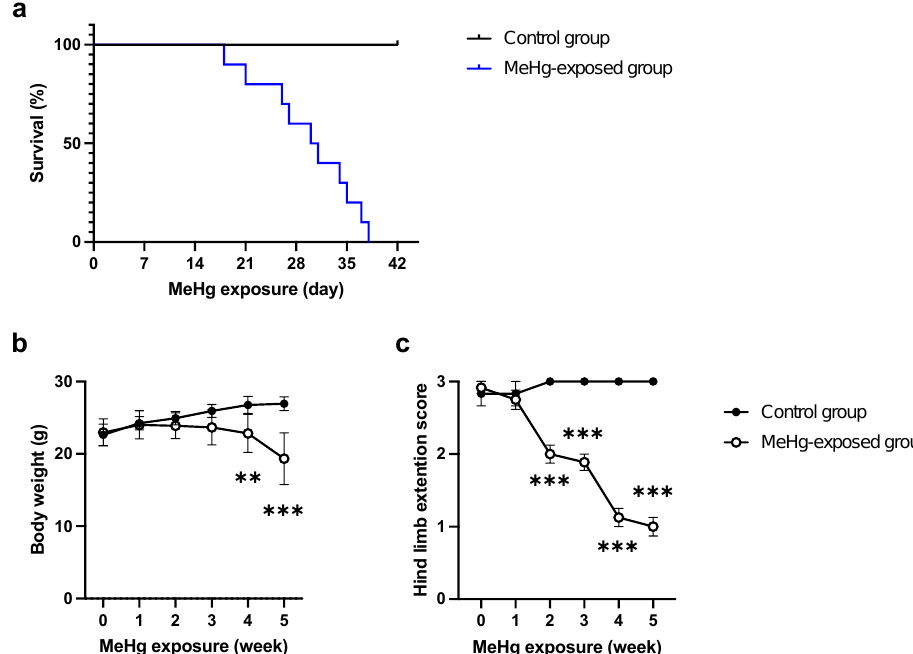
Figure 1. Sensitivity to MeHg exposure in ERAI-Venus mice in vivo. Mortality ( a ), body weight ( b ), and hind limb extension ( c ) in MeHg-exposed ERAI-Venus mice. MeHg-exposed mice were administered 50 ppm MeHg via drinking water. Data are expressed as the mean ± S.E.M. values (n = 10, ** p < 0.01, and *** p < 0.001: significant difference compared with control mice by two-way ANOVA with Tukey’s post hoc test).